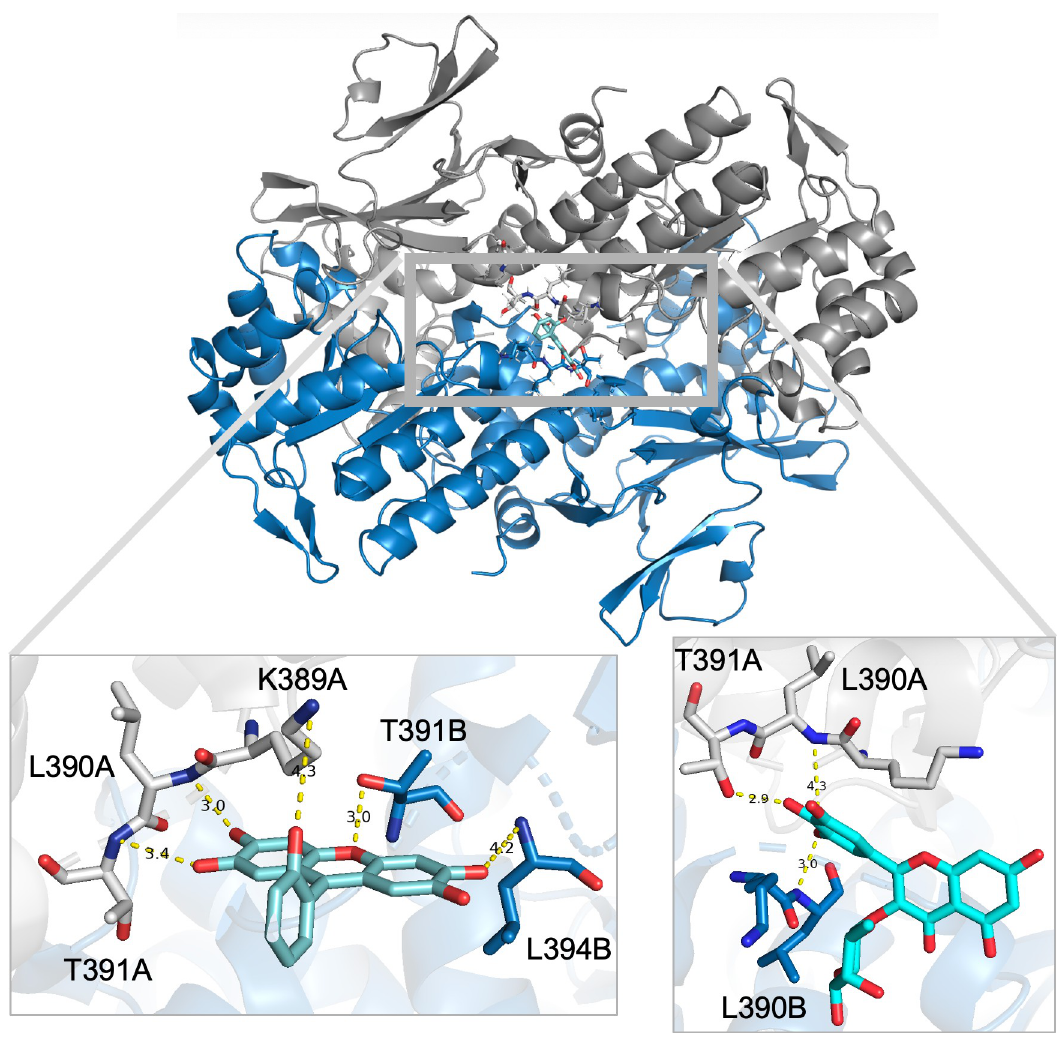
Fig 10. Theoretical interaction between NAMPT K389 cavity and novel activators. Molecular images were visualized using the educational version of PyMOL version 1.2 from Schrodinger, LLC. in the context of an undergraduate research experience. The active NAMPT dimer is represented in the top panel, with the K389 cavity highlighted in the gray box. Autodock Vina results of compound 20 docked into the search space suggests hydrogen bonding between compound 20 and individual NAMPT monomer units. (Left Panel) Autodock Vina results of compound 2 docked into the search space suggests hydrogen bonding between compound 2 and individual NAMPT monomer units. (Right Panel) There is no suggestion that the molecules will bind